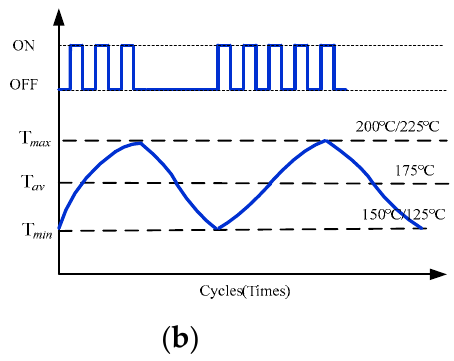
Figure 3. Accelerated life test control process: ( a ) Control flowchart; ( b ) Temperature cycle. Table 3. Frequency and temperature swing of cycle test.